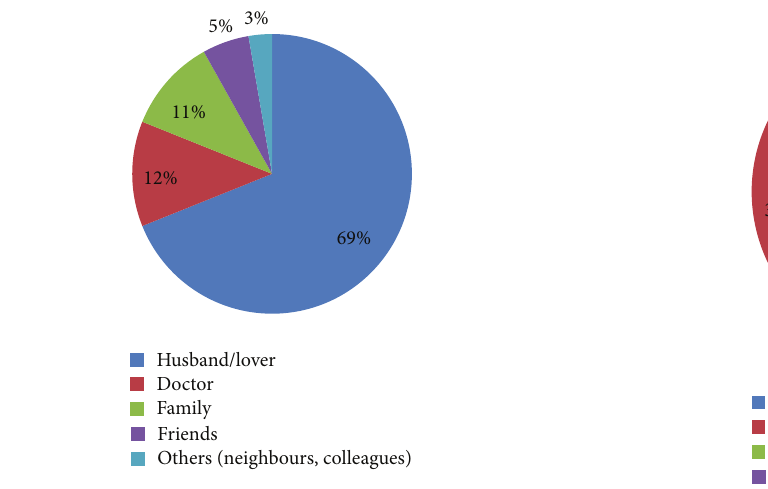
Figure 1: People respondents consulted when they were sad or lost interest in their routine activities ( 𝑁 = 74 ).